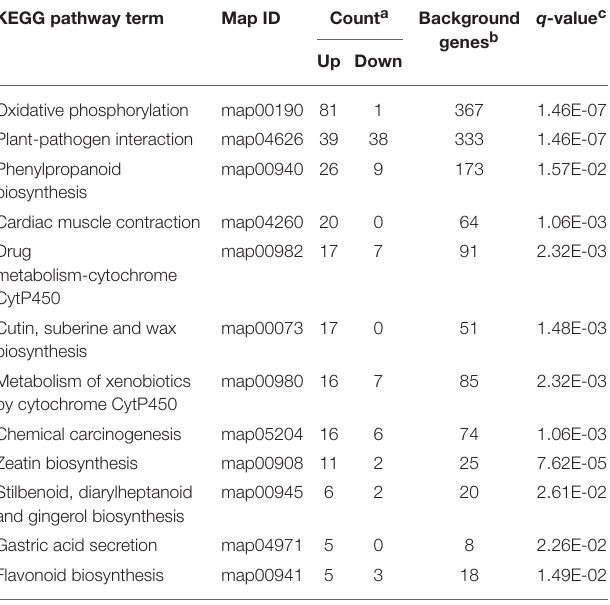
TABLE 4 | The 12 enriched KEGG pathway terms of the DEGs between mesosulfuron-methyl treated R (AH18) and S (SD01) Alopecurus aequalis